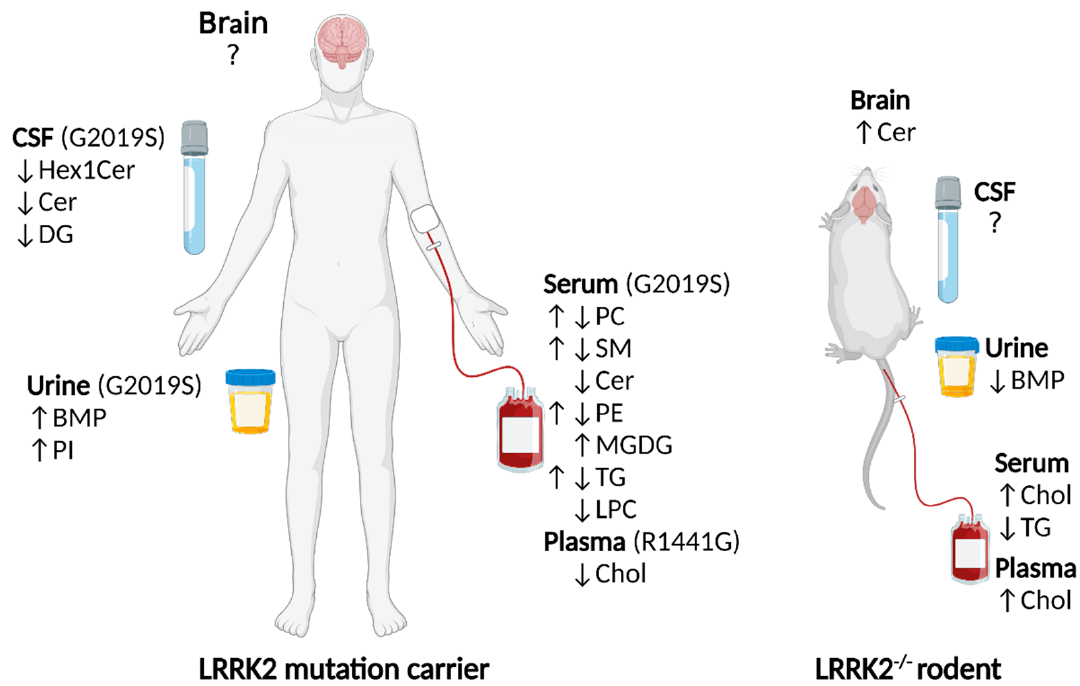
Figure 2. Lipid level changes in tissues from LRRK2 mutation carrier humans and LRRK2-/- rodents. Human LRRK2 G2019S mutation carriers have alterations in serum phospholipid, sphingolipid and glycerolipid species, and CSF sphingolipid and glycerolipid species compared to those without a LRRK2 mutation [26]. Human LRRK2 G2019S mutation carriers have increased BMP and PI species in urine compared to those without the mutation [24]. Human LRRK2 R1441G mutation carriers have decreased plasma cholesterol [22]. LRRK2-/- rats have higher serum [15] and plasma [16] cholesterol, and lower serum triacylglycerol [15] compared to WT. LRRK2-/- mice have increased brain ceramide [13] and decreased urine BMP [14] compared to WT. For simplicity, specific lipid species are not depicted (detailed lipid species information is included in sections 1.3 and 1.4). Hex1Cer = hexosylceramide, Cer = ceramide, DG = diacylglycerol, BMP = bis (monoacylglycerol) phosphate, PI = phosphatidylinositol, PC = phosphatidylcholine, SM = sphingomyelin, PE = phos- phatidylethanolamine, MGDG = monogalactosyldiacylglycerol, TG = triacylglycerol, LPC = lyso- phosphatidylcholine, Chol = cholesterol. Created with BioRender.com (accessed on 26 Oct 2022).